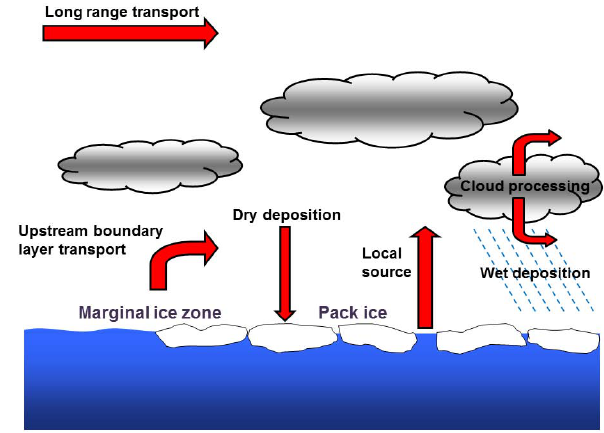
Fig. 15. Graphical representation of the sources and transport mech- anisms of aerosol particles over the summer Arctic pack